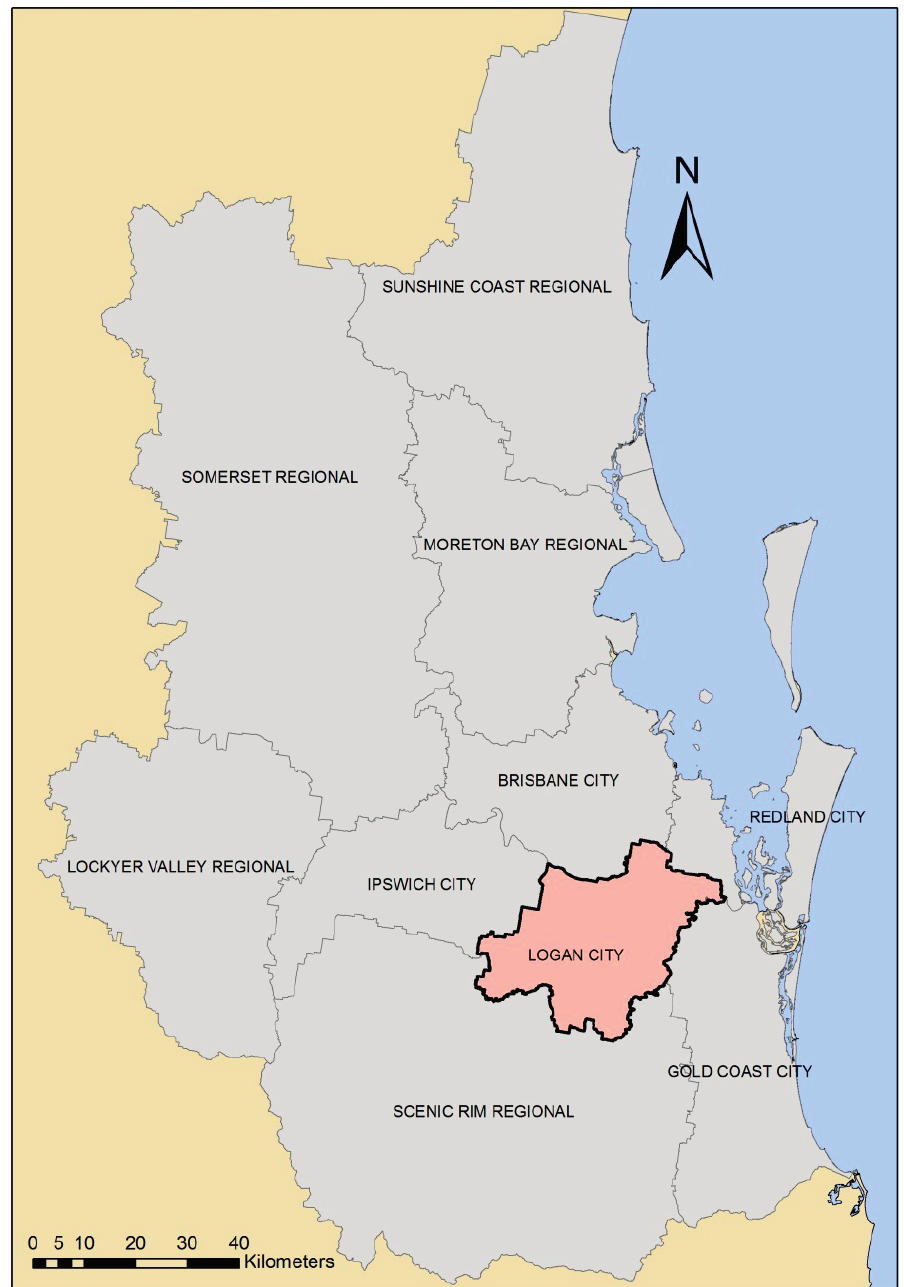
Figure 1. Logan City in South East Queensland,